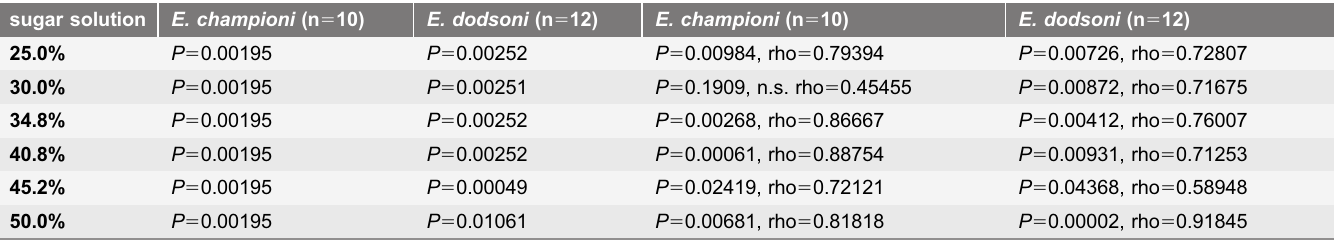
Table 2). Evaporative water loss from the artificial feeders during the respective days led to values maximally 1% higher than the sugar concentration measured in the morning (Table 2), and could therefore not have been responsible for the higher concentrations found in the crop contents.